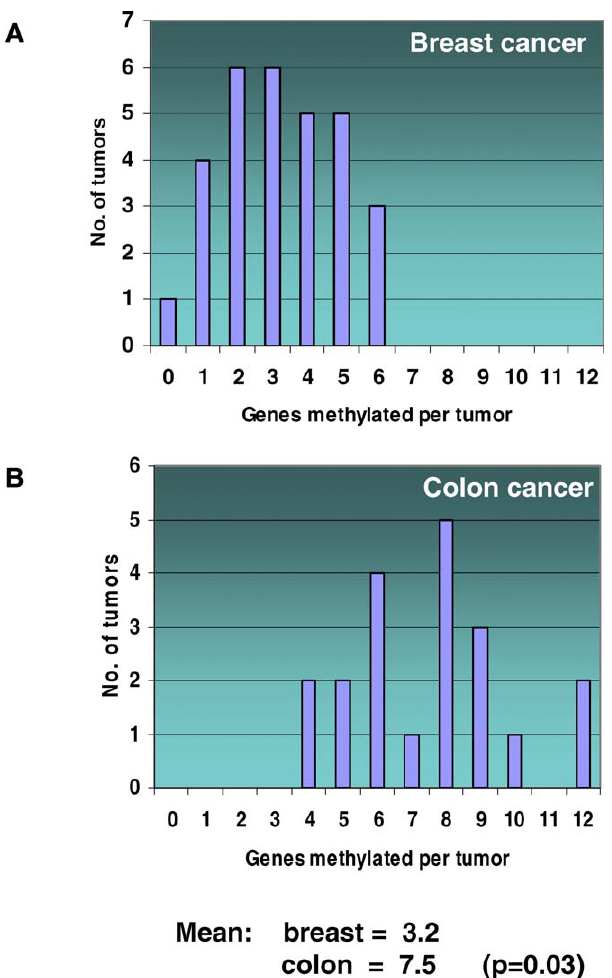
Figure 6. Patterns of Mutation and Hypermethylation in Breast and Colon Cancer (A) Frequency of cancer-specific hypermethylation of CAN genes. Data were generated from analysis of only the 18 genes demonstrating cancer-specific hypermethylation. Results for breast cancer. p -Value was calculated using Student’s t -test. (B) Results for colon cancer.